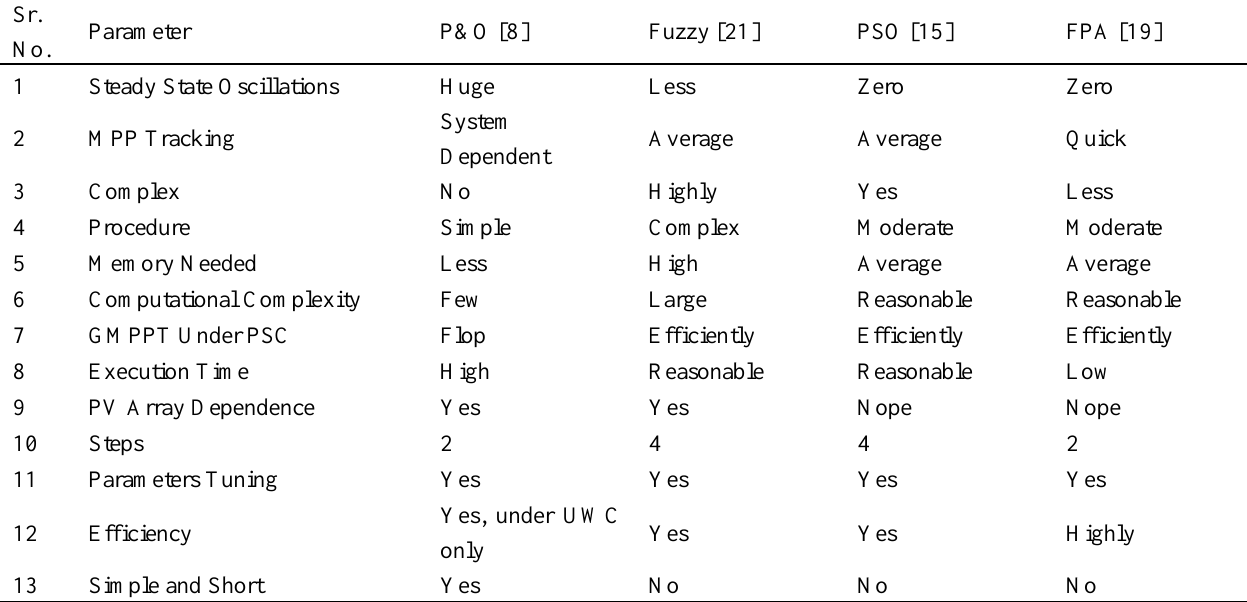
Overview of renowned conventional and nature inspired MPPT algorithms